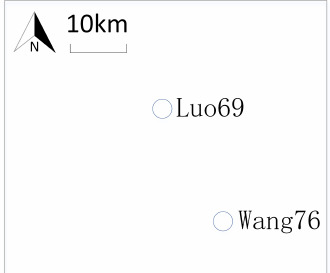
Figure 1. Relative location of logs in the study area.